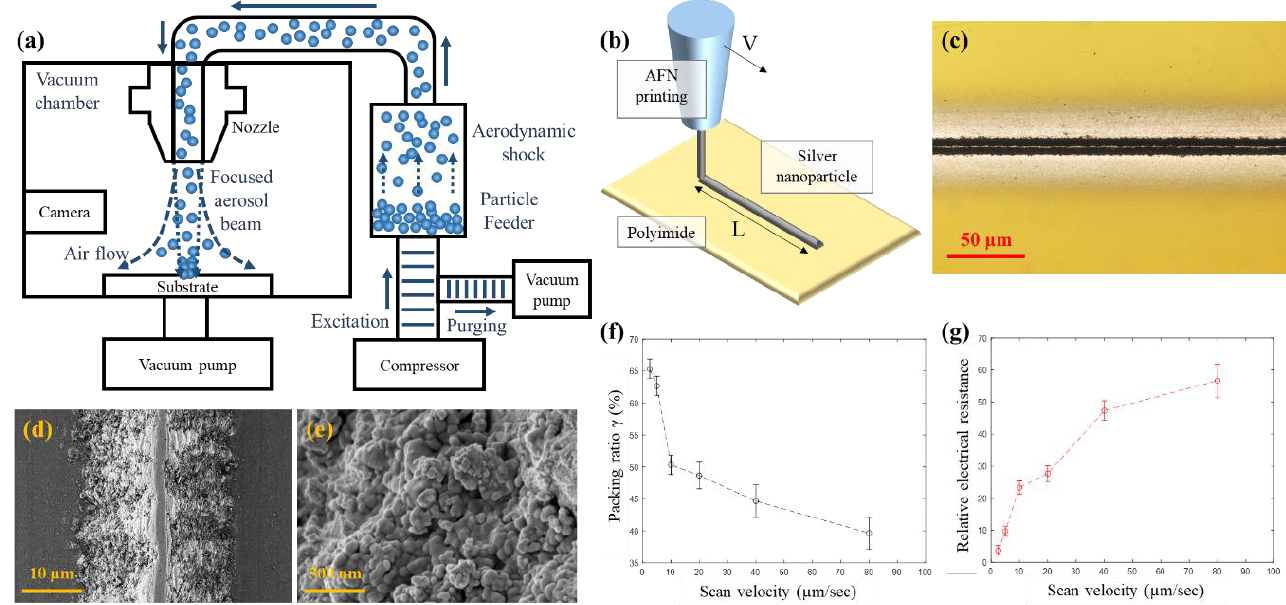
Figure 1. ( a ) Schematic diagram of the aerodynamically focused nanomaterial (AFN) printing system. ( b ) Schematic illustration of AFN printing of silver nanoparticle onto polyimide substrate. ( c ) Optical microscope image of AFN-printed microscale conductive line pattern. ( d , e ) Scanning electron microscope images of AFN-printed microscale conductive pattern. ( f ) Nanoparticle packing ratio with respect to the scan velocity. ( g ) Relative electrical resistance with respect to the scan velocity.